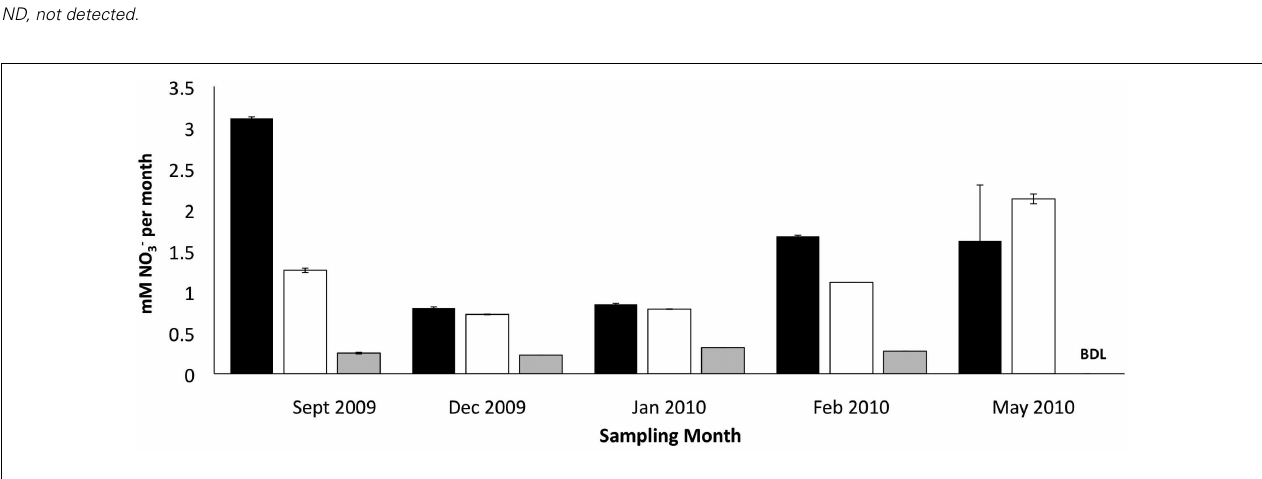
zeolite addition (gray bars). Error bars represent standard deviation of 3 duplicate measurements for each sample. Samples were collected from sites 1 and 3 ( Figure 1 ), and rate measurements were combined to calculate final rates and standard